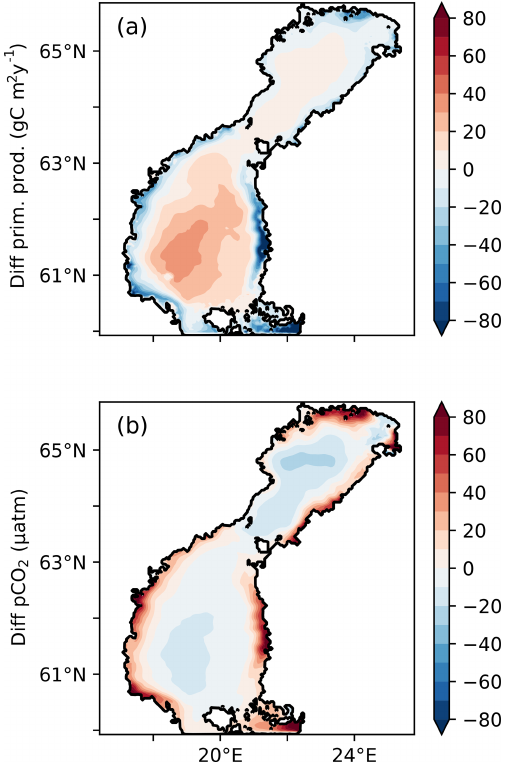
Figure 7. Difference in (a) vertically integrated primary production (gCm − 2 yr − 1 ) and (b) p CO 2 (µatm), between the 1Y and 1YS experiments. Table 3. Primary production (1990–2010) in gCm − 2 yr − 1 in the 1Y and 1YS experiments (relative change with respect to